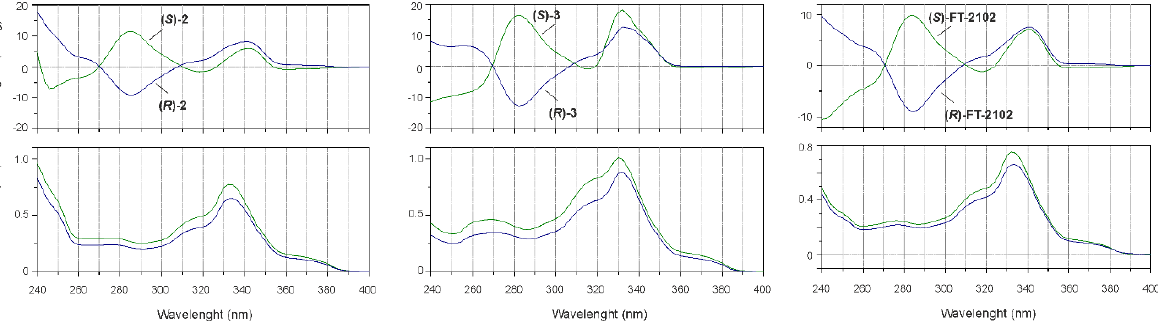
Figure 4. CD and UV spectra of ( S )- and ( R )- 2 , ( S )- and ( R )- 3, and ( S )- and ( R )-FT-2102 measured with a chiral HPLC in stopped-flow mode (different compositions of ACN/aq. 20 mM NH 4 OAc as mobile phases).